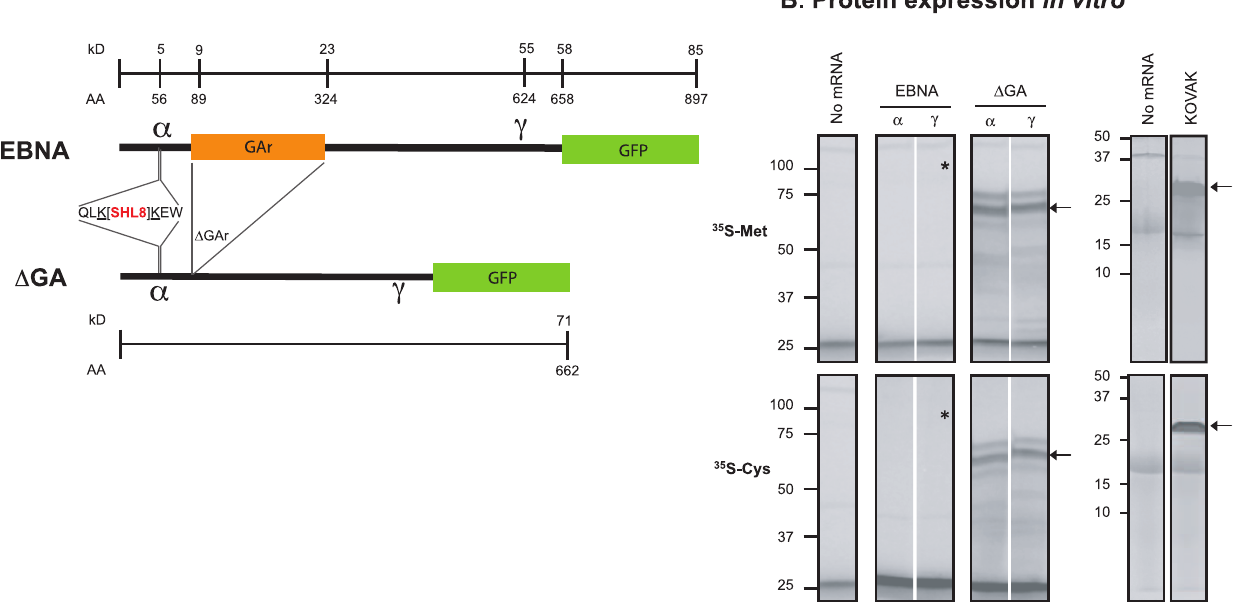
Figure 1. Schematic representation of cDNA constructs encoding EBNA1 and its EBNA1 D GA derivative lacking the glycine-alanine repeat (GAr). To track the translated products, the OVA-derived epitope (SIINFEHL or SHL8) was inserted in either the N-terminal (position a ) or C- terminal region (position c ) of EBNA-GFP or its D GA derivative. The SHL8 antigenic peptide was flanked at its N- and C-termini by lysines (QLK- and – KEW) to allow detection of potential antigenic intermediates containing the SHL8 peptide by enzymatic methods. The number of amino acids and the predicted molecular weights of putative polypeptides are shown. ( B ) Invitro expression EBNA1 and EBNA1 D GA full-length proteins. The mRNAs encoding EBNA1 ( a or c ) and EBNA1 D GA ( a or c ) were transcribed in vitro , purified and translated in a rabbit reticulocyte lysate in the presence of radiolabeled 35 S-Met or 35 S-Cys as tracers. The translated products were fractionated on 7.5% SDS-PAGE gels and detected by PhosphoImager. As controls, translation was carried out in parallel without mRNA (no mRNA) or with mRNAs encoding the 27kD KOVAK protein. Arrows indicate the predominant products from translation of D GA a , D GA c and KOVAK mRNA (73 and 27 kD respectively). The expected location of the 86 kD product of EBNA a and EBNA c translation is indicated by an asterisk. Autoradiographs on right show the KOVAK translated products fractionated on higher resolution 16.5% SDS-PAGE. Data shown is representative of 3 different experiments.